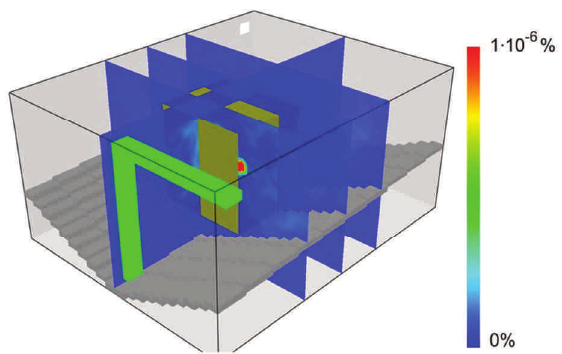
Fig. 10. DME volumetric concentration in the air, leakage variant I